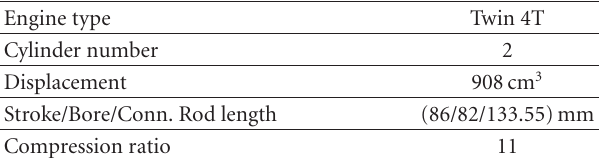
Figure 17: blow-by flow rate in PRL volumes, β = 5, stable model. Table 2: Features of the analyzed engine.